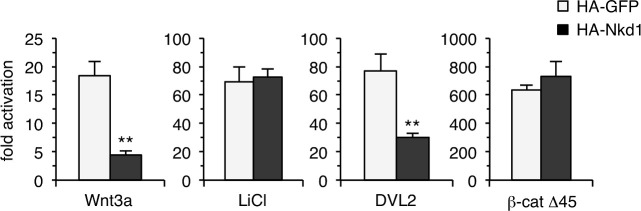
Effects of overexpressed NKD1 on β-catenin signaling.SuperTOP assays in transfected HEK293T cells, monitoring the effects of overexpressed HA-Nkd1 on β-catenin-dependent transcription in response to stimulation for 6 hr with Wnt3a-conditioned media or 20 mM LiCl (control 20 mM NaCl), or to overexpressed DVL2-GFP or activated β-catenin (β-cat Δ45) in transfected HEK293T cells; error bars, SEM of > 3 independent experiments; Student’s t-test; **p < 0.01.